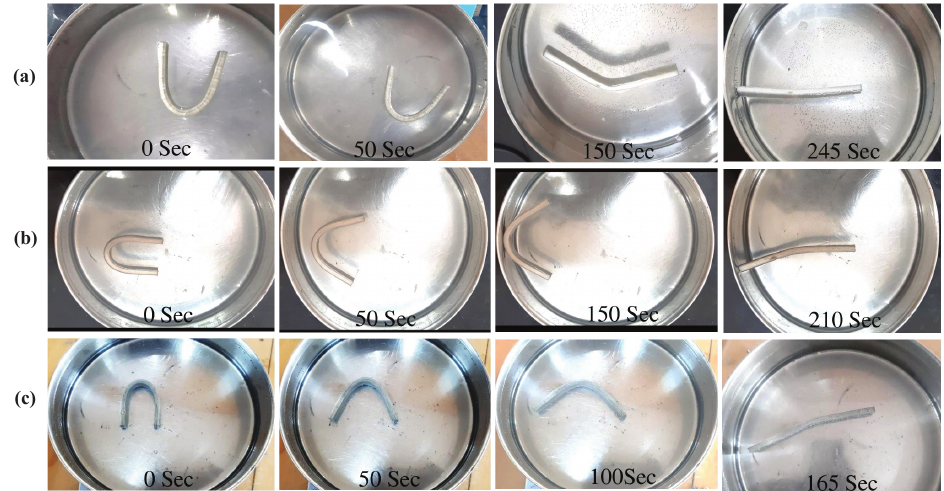
Figure 11. Shape recovery of ( a ) pure SMPU, ( b ) 0.5 wt% HNT-reinforced, and ( c ) 1% HNT-reinforced specimens at various time frames when placed in the water bath (at 80 ◦